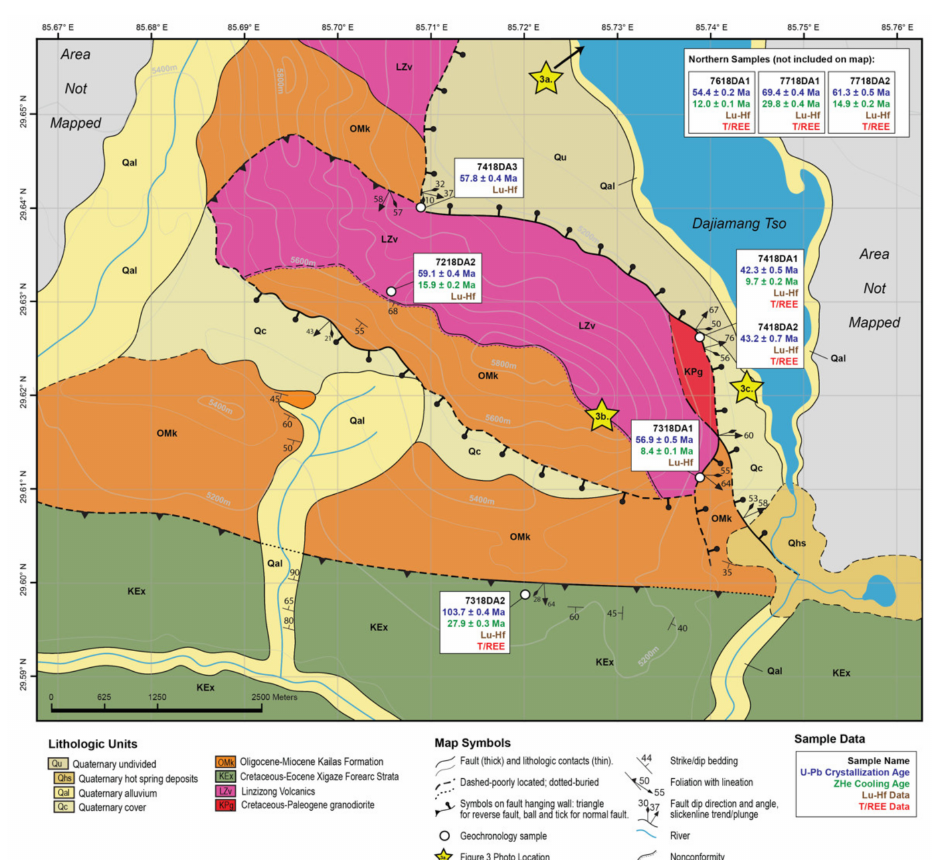
Figure 2. Geologic map of the Dajiamang Tso rift field area (1:40,000 scale) highlighting lithologic units, structures, and sample locations. Sample locations are represented by white circles, with the sample name, U-Pb geochronology crystallization age, ZHe thermochronology cooling age, and indicators for Hf and T/REE datasets included in adjacent information panels. Gold stars represent the locations of the field photos. Data for overlapping structural measurements were averaged for map clarity. Information panels for three samples collected north of the mapping area are also provided in the top right corner of the